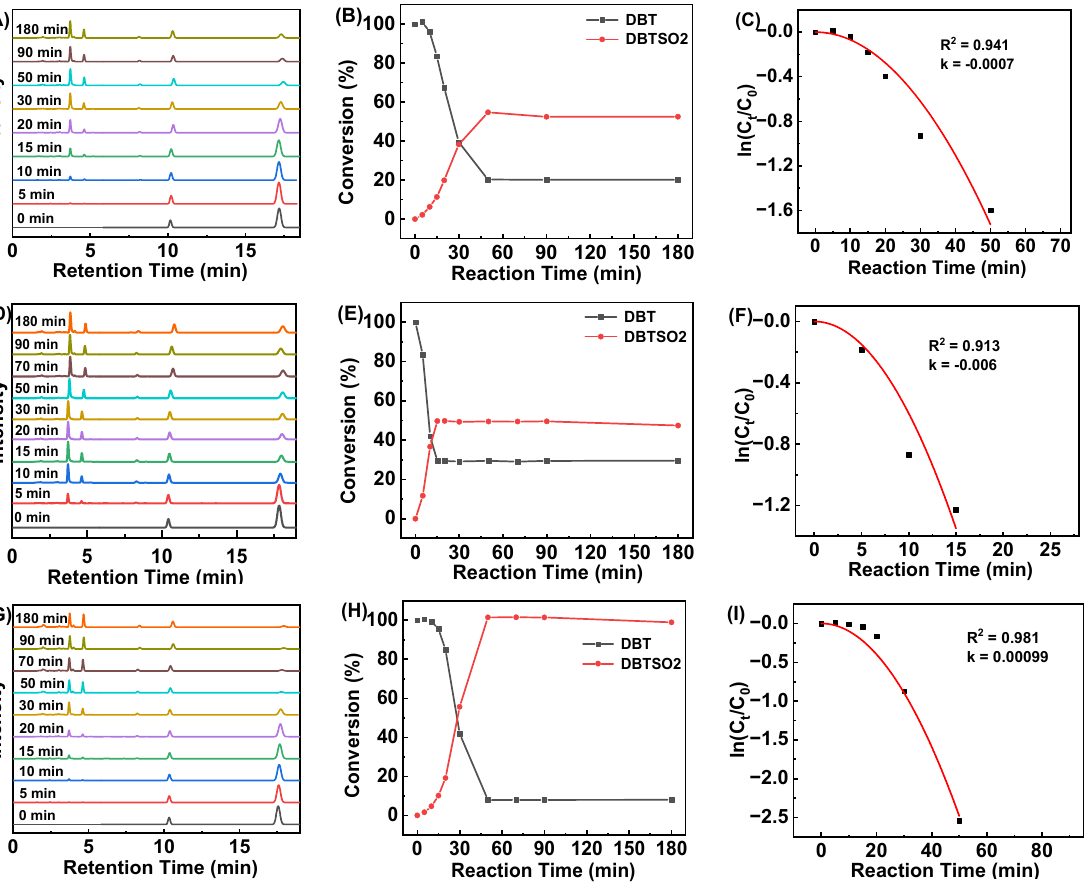
Figure 6. HPLC spectra, conversion curves, and kinetics curves during the catalytic oxidation of DBT by HCCP-V under different conditions: ( A – C ) 70 °C, 5 eq of H 2 O 2 , ( D – F ) 80 °C, 5 eq of H 2 O 2 , and ( G – I ) 70 °C, 8 eq of H 2 O 2 . Naphthalene with a retention time of 10.2 min was used as an internal standard. Table 2. The catalytic oxidation results of DBT by HCCP-V in CH 3 CN.